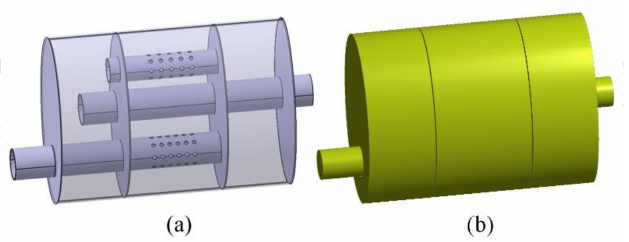
Figure 7. 3D geometrical model for the three-pass perforated tube silencer: ( a ) structural model; ( b ) flow field model.